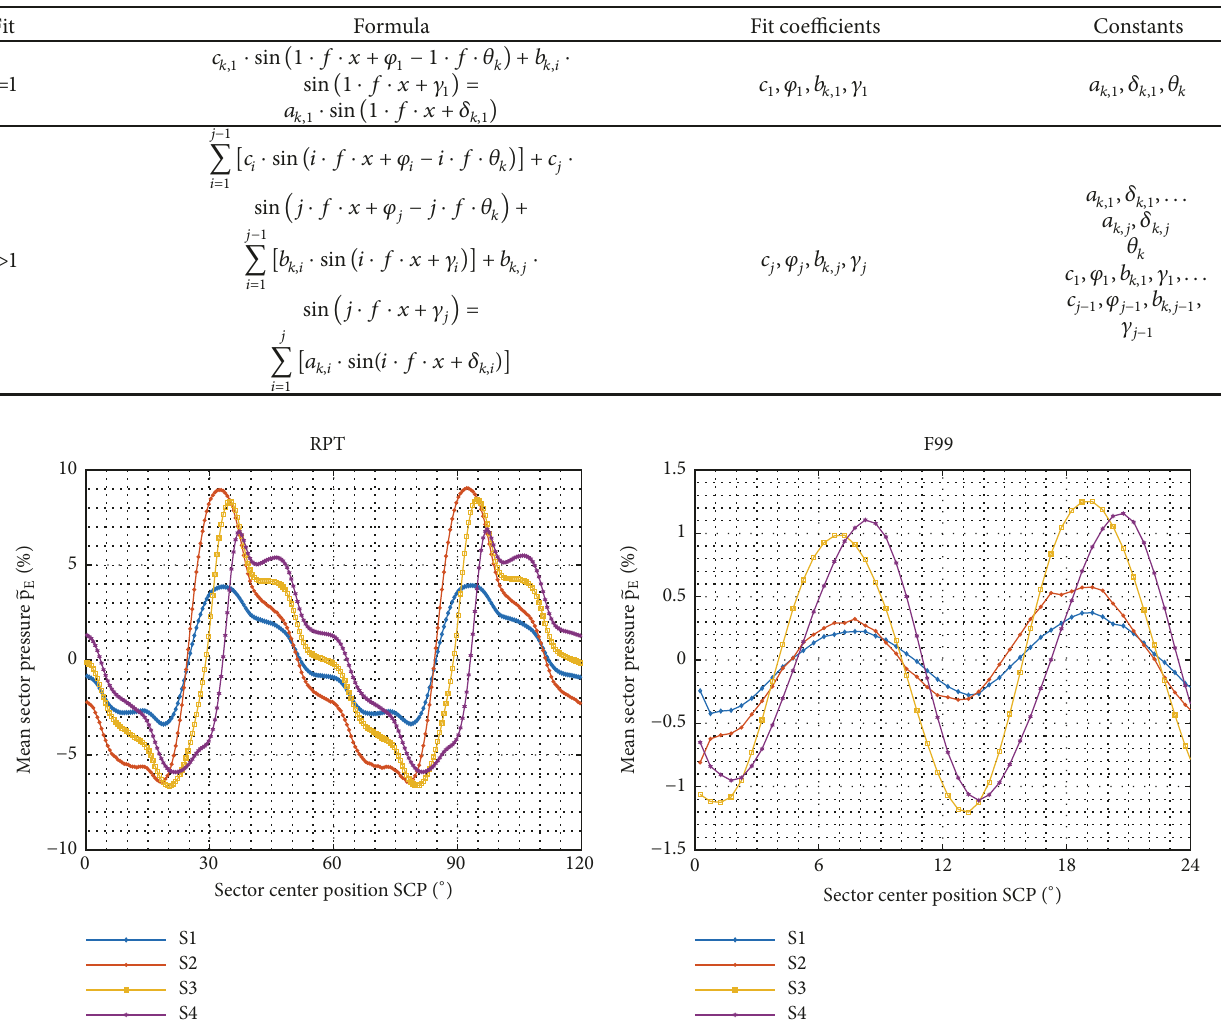
Figure 5: The mean sector pressure from the pressure sensors as percentage of specific energy. The angular size of each sector was 0.5 ∘ , with 720 sectors in total. The mean sector pressure was calculated from 600 full